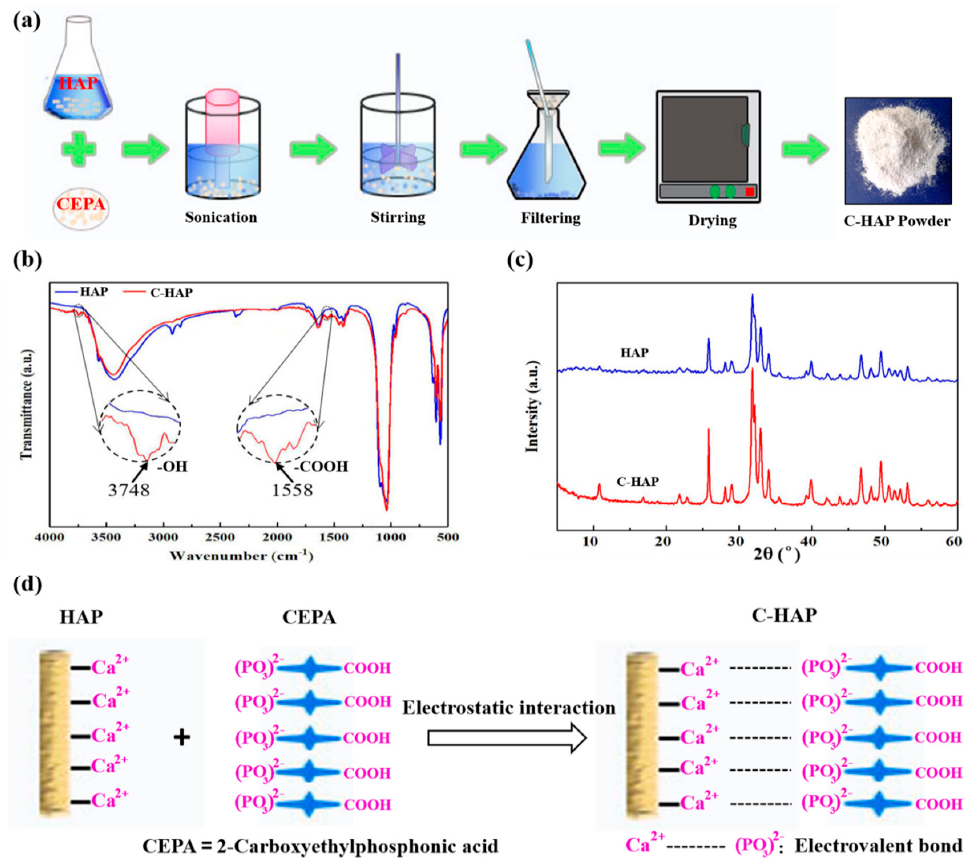
Figure 1. ( a ) The fabrication process of 2-carboxyethylphosphonic acid-modified hydroxyapatite (C-HAP) was powder, ( b ) Fourier transform infrared spectroscopy (FTIR) spectra and ( c ) X-ray di ff ractometry (XRD) pattern of C-HAP and hydroxyapatite (HAP), ( d ) Schematic of the possible interactions between HAP and Table 1. Material compositions of the composite powder.